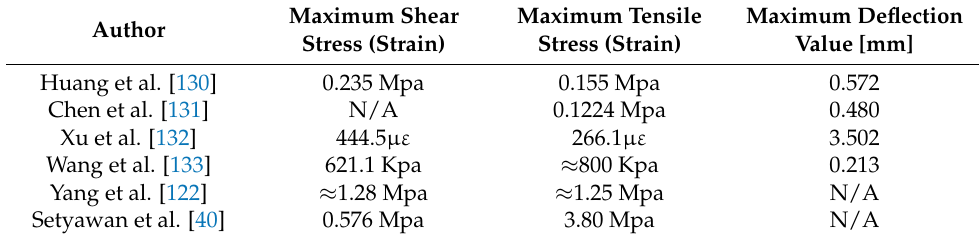
Table 14. Results of FEM